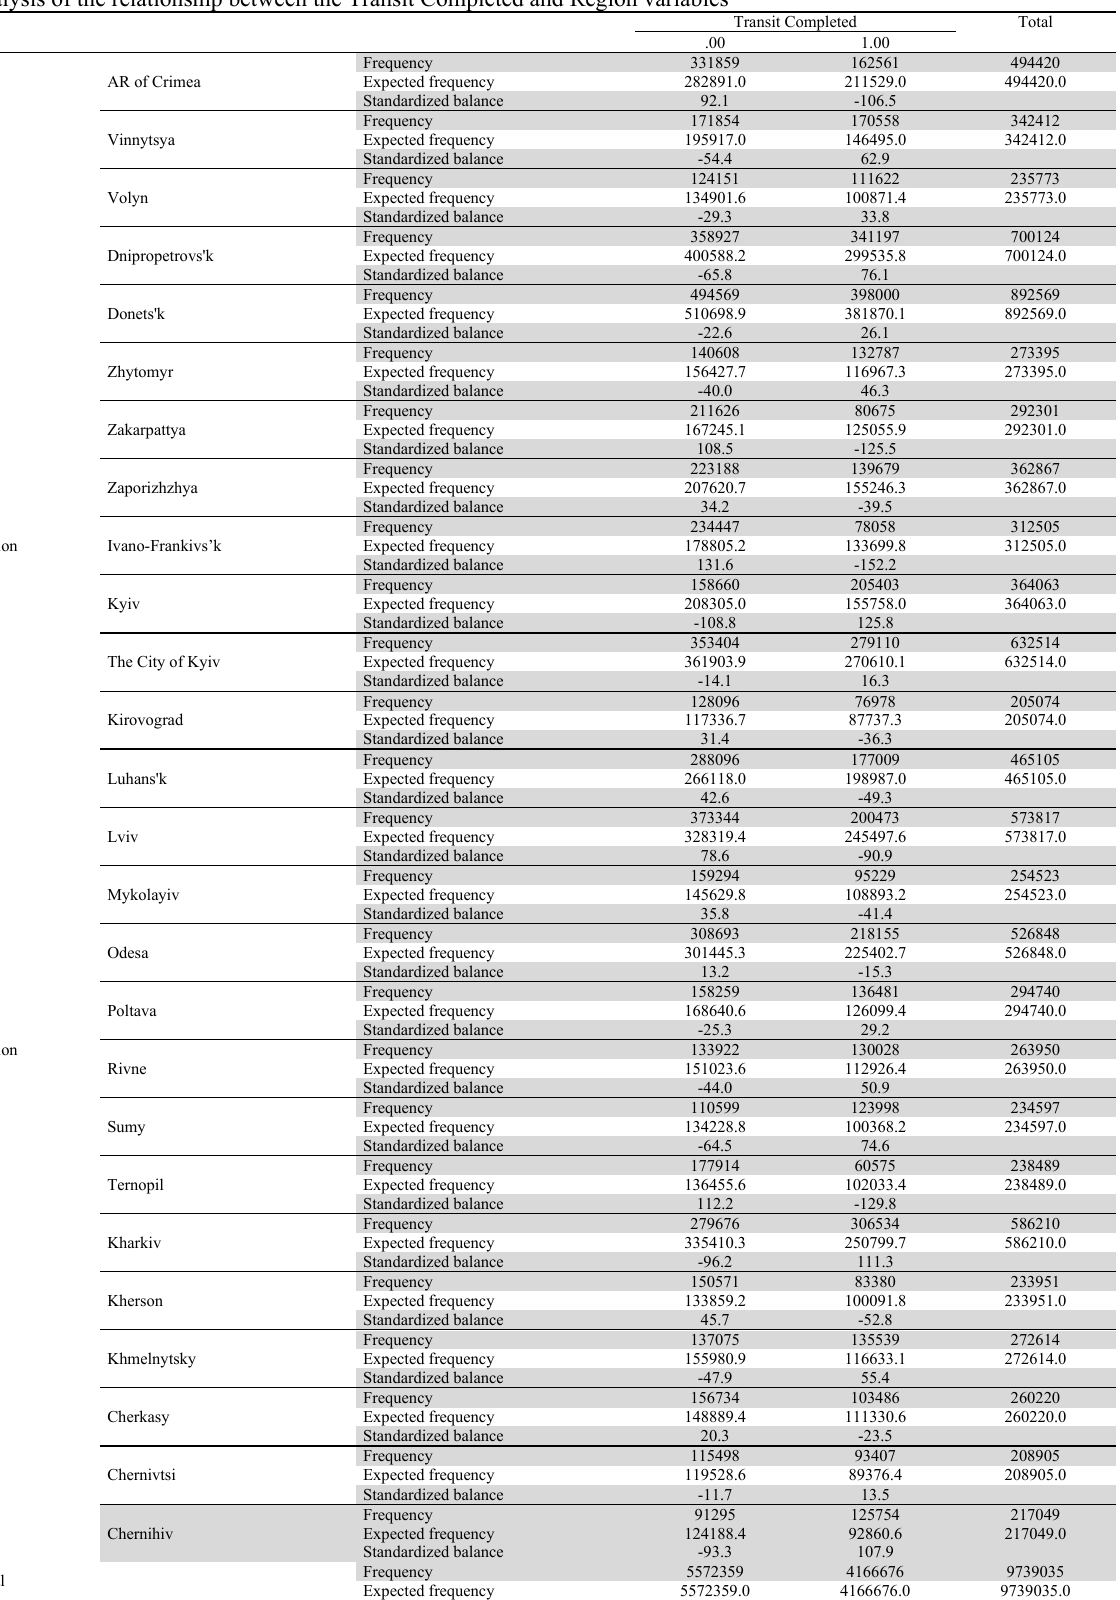
Analysis of the relationship between the Transit Completed and Region variables